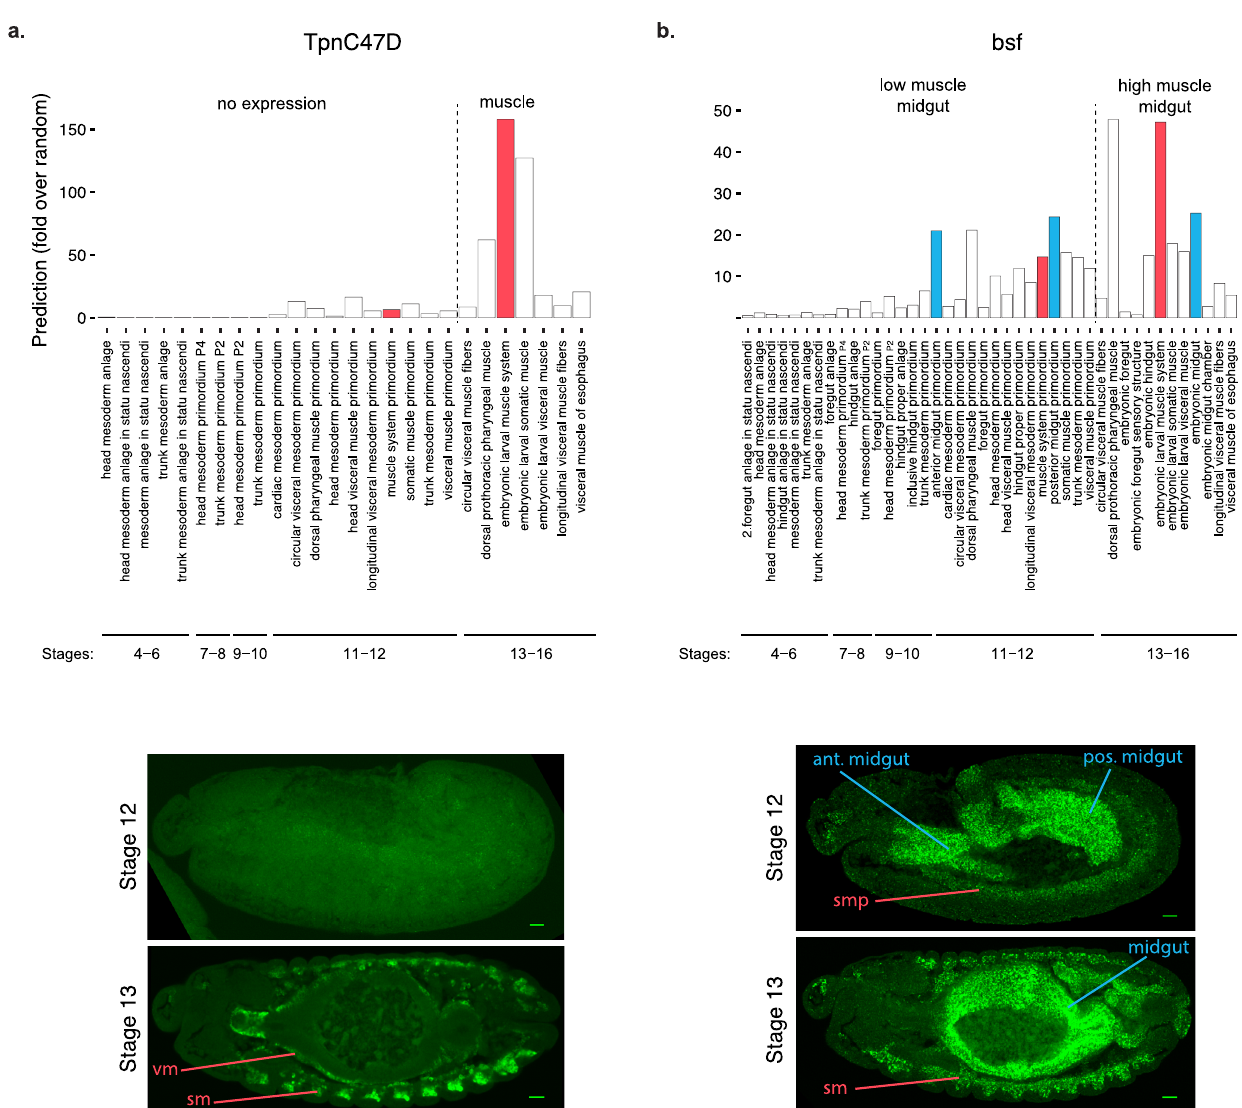
Fig 4. FISH validation of FIND temporal dynamics predictions. a. Expression prediction for TpnC47D up-regulation in muscle. Top. fold enrichment values of the TpnC47D gene for all BDGP terms including either “muscle” or “mesoderm”, ordered from earliest to latest. The terms “Stage 11–12 muscle system primordium” and “Stage 13–16 embryonic larval muscle system”, which represent the same group of structures in different stages, have been colored in red. Bottom. FISH images of the TpnC47D gene expression in stage 12 and stage 13 embryos. b. Prediction of relative changes in expression between muscle and gut for the bsf gene. Top. Same as in a, but also including gut-related terms. Midgut terms for Stage 11–12 and Stage 13–16 BDGP intervals have been colored in blue. Bottom. FISH images of the bsf gene expression in stage 12 and stage 13 embryos.